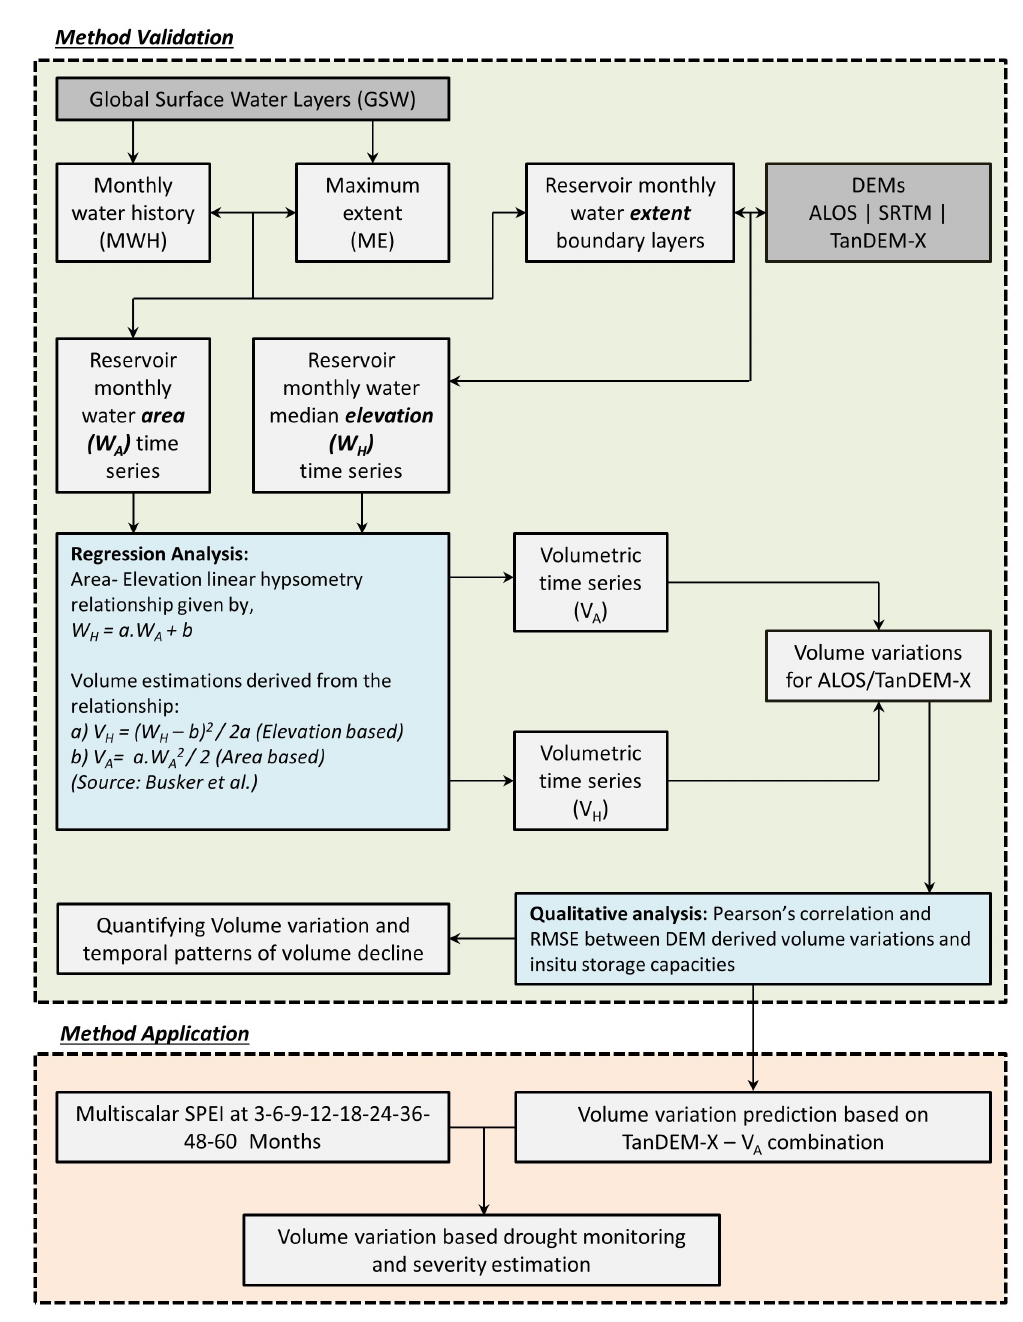
Figure 2. Workflow: Adaptation of Area–elevation hypsometric relationship to estimate volume variations in drought prone Californian